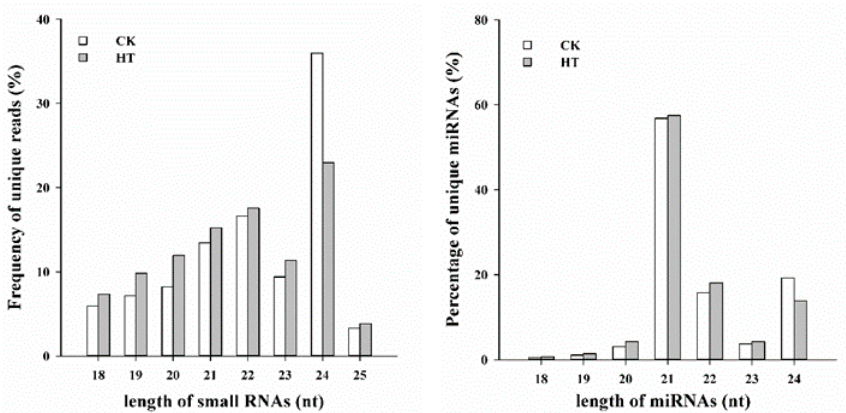
Figure 2. Size distribution of unique small RNAs and miRNAs detected by deep sequencing.